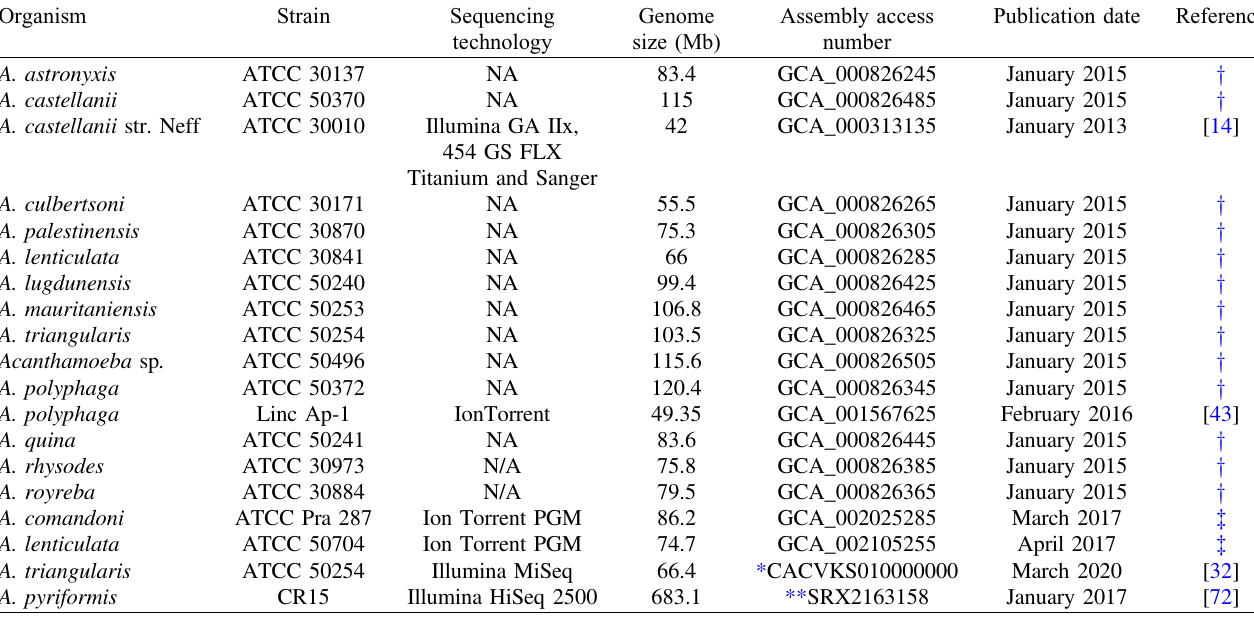
Table 3. Representative genomes of Acanthamoeba spp. available and collected from GenBank, and corrected through information provided by Fuerst (2020).